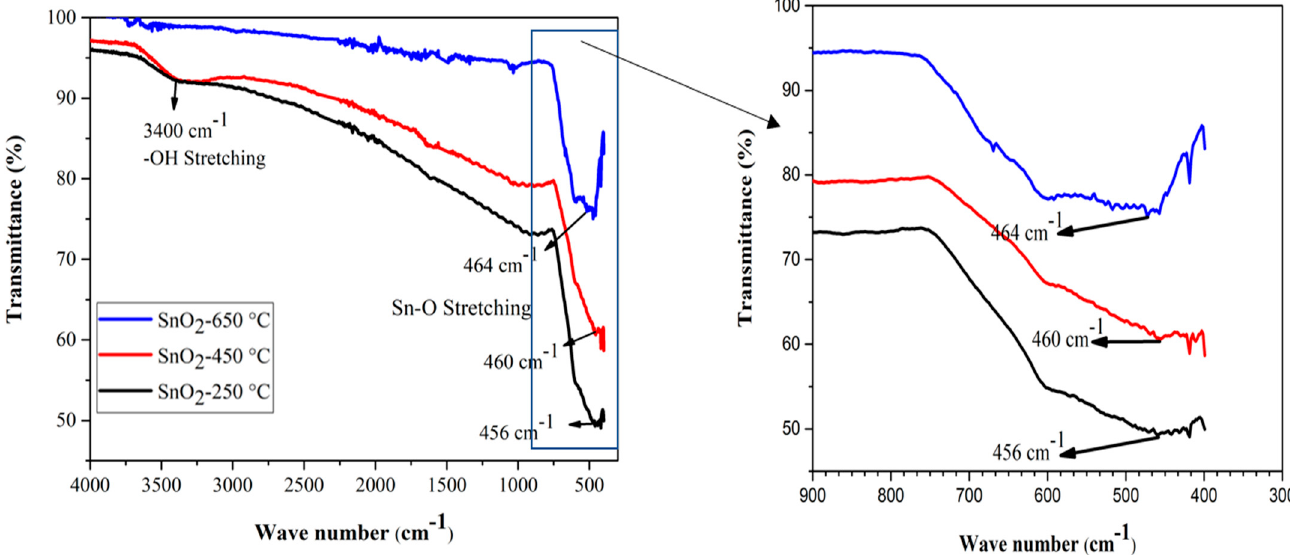
Figure 2. FTIR spectra of SnO 2 nanoparticles at various calcination temperatures.